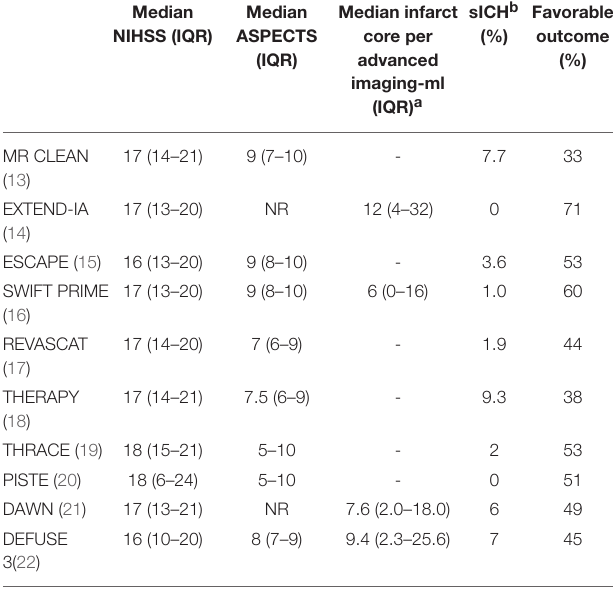
TABLE 2 | Clinical-infarct volume mismatch as eligibility criteria for EVT in recent landmark